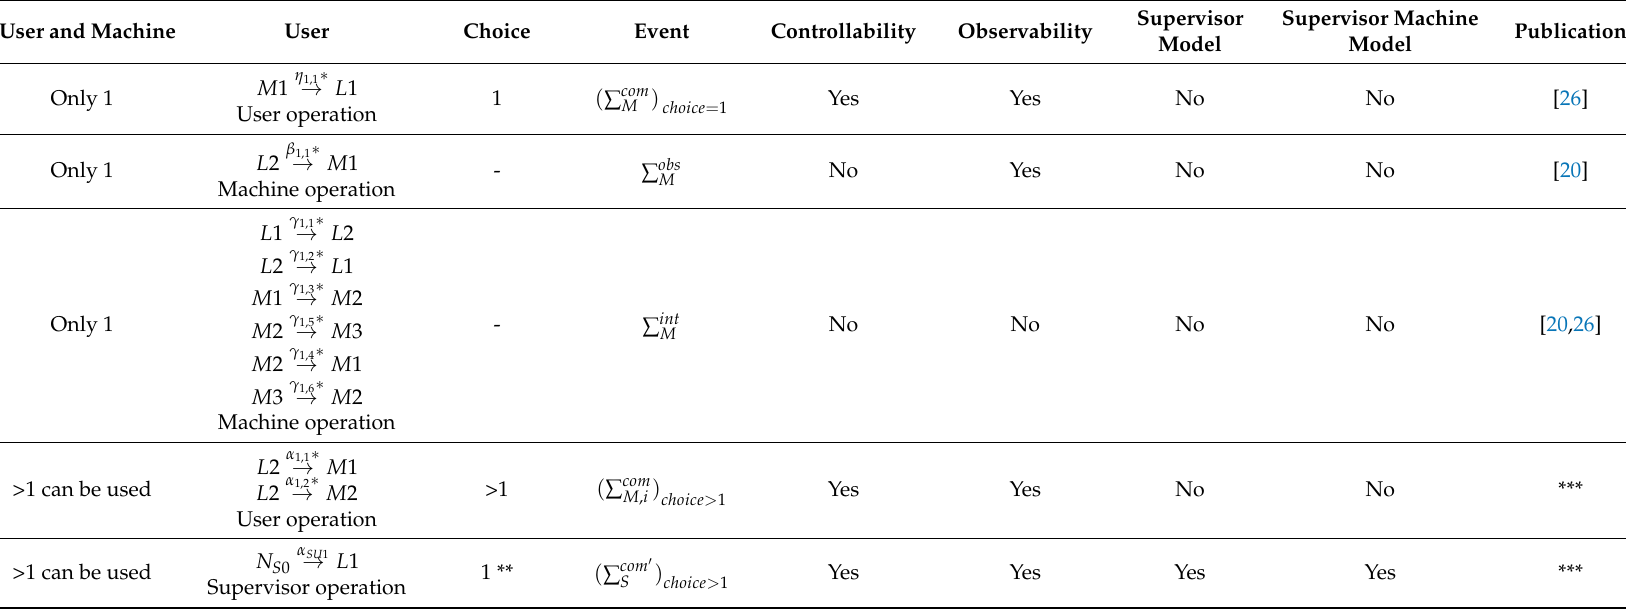
Table 1. Event execution based on criteria of observability and controllability through user and machine